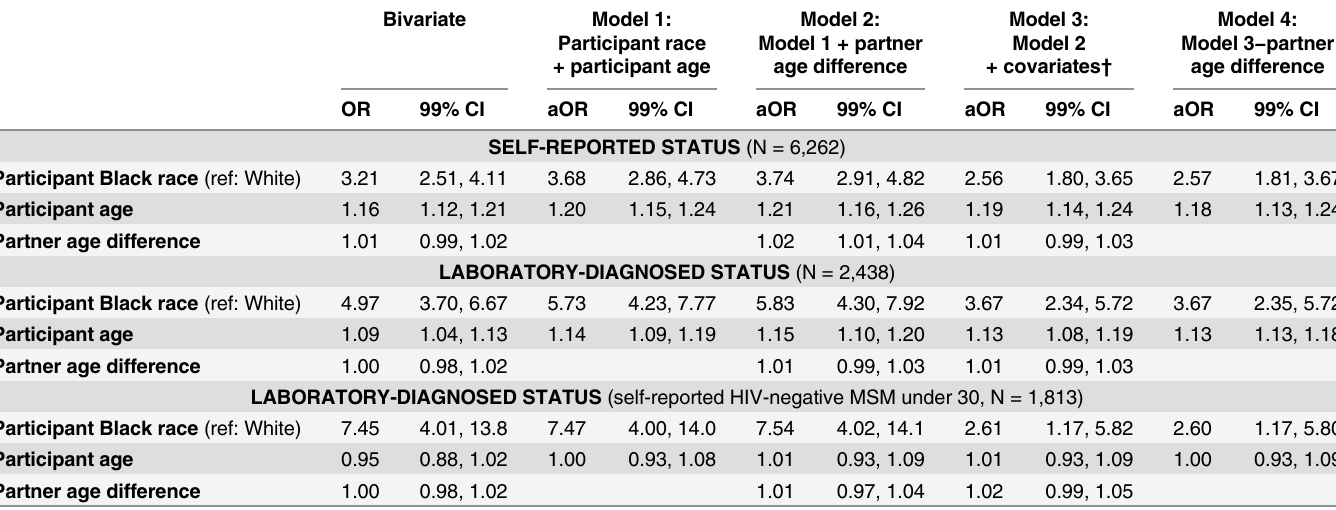
Table 3. Crude and adjusted odds of HIV-positive serostatus, measured by self-report (4 studies, N = 6,262), laboratory diagnosis (2 studies, N = 2,438), and laboratory diagnosis restricted to self-reported HIV-negative MSM under the age of 30 (2 studies, N = 1,813). Bivariate Model 1: Participant